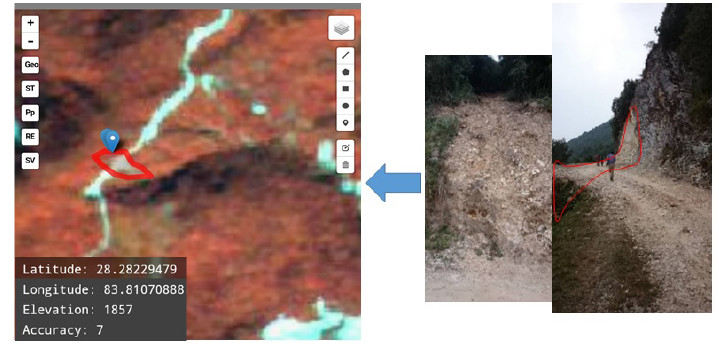
Figure 11. Data collection close to the event where usually a landslide happened near a road and was possible to access.